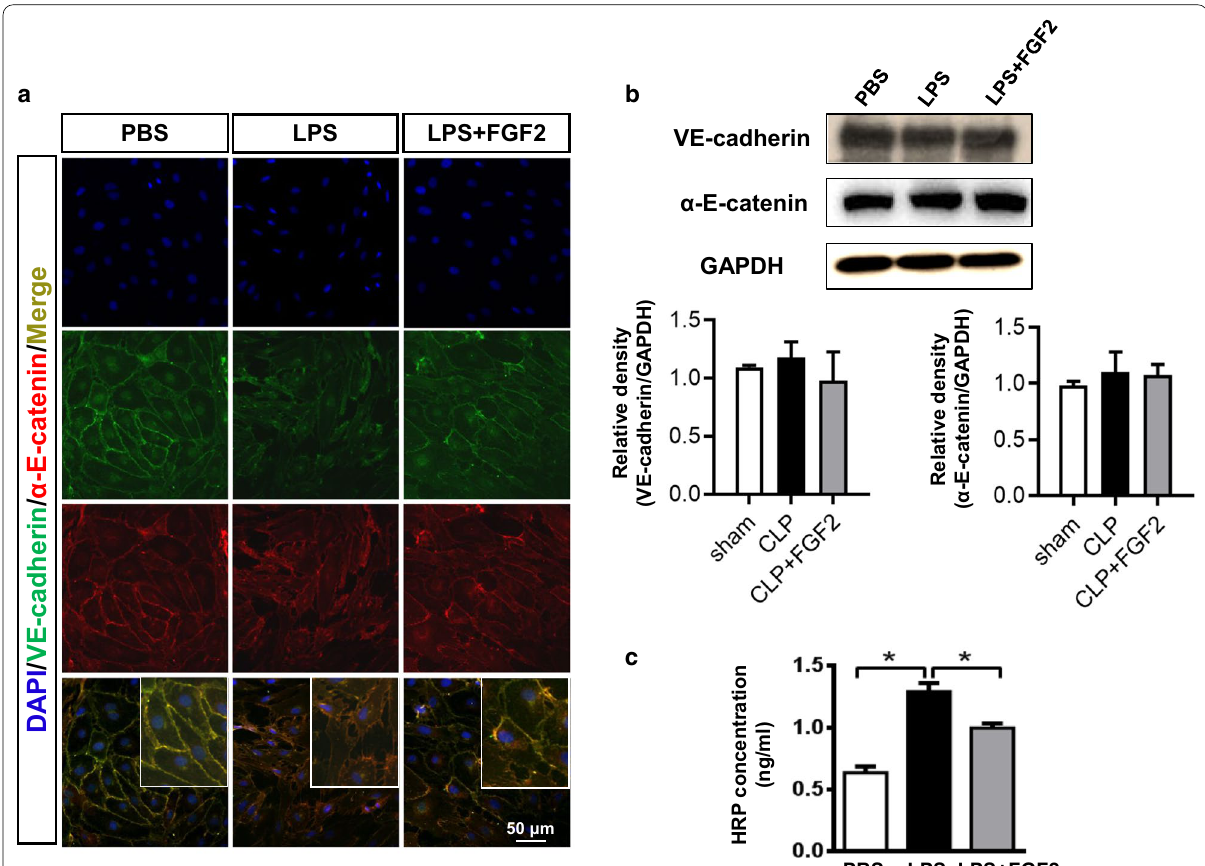
Fig. 5 FGF2 protects the HPMECs permeability from LPS by stabilizing VE-cadherin and α-E-catenin. a The VE-cadherin and α-E-catenin was stained by cytofluorometry. The pictures are all shown at 400 magnification. b The protein levels of intercellular connectivity VE-cadherin and α-E-catenin × in HPMECs 6 h after LPS were evaluated by western blot and the relative densities were analyzed (n 3 per group, GAPDH was used as internal ≥ control). c HPMECs were seeded into the upper chamber of Transwell (0.4 μm) with different treatments for measuring the HRP condition (n 3 per ≥ group). Data are represented as mean SEM. * P < ±